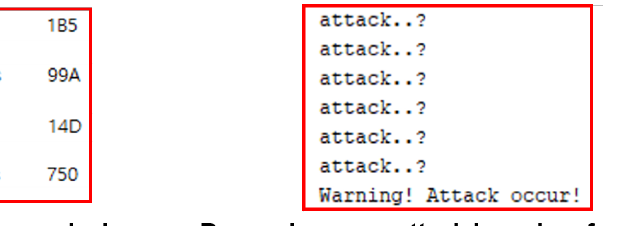
Figure 16. In this figure, the evaluation target node that received the BSMs sent by the verification node recognizes that the changes in the speed value are not normal and recognizes the attack, since the changes occurred more than a certain number of times within a certain time. In this study, we used simple misbehavior and IDS, but in real tests, the misbehavior detection ability of the IDS should be verified using various types of attacks.